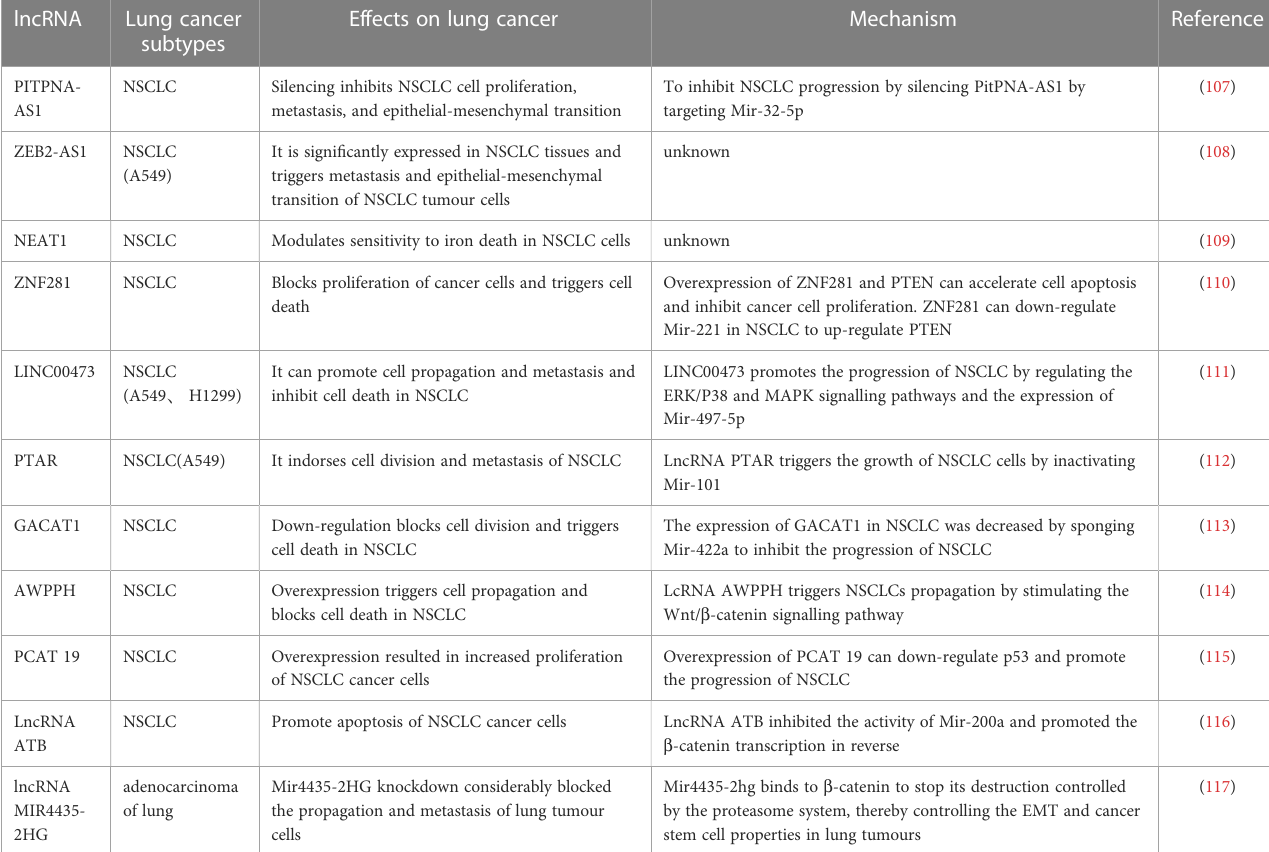
TABLE 3 Regulation of lncRNAs in lung